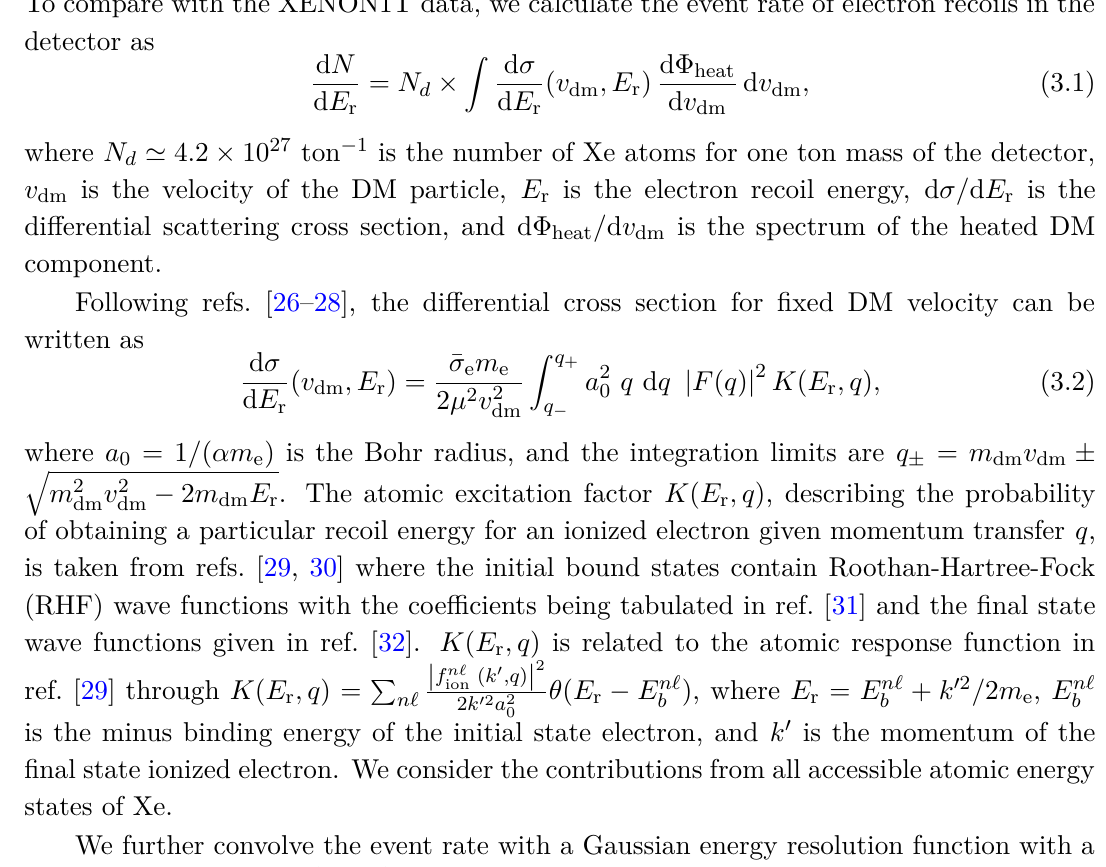
, and F = ( q ) 2 , αm e αm e